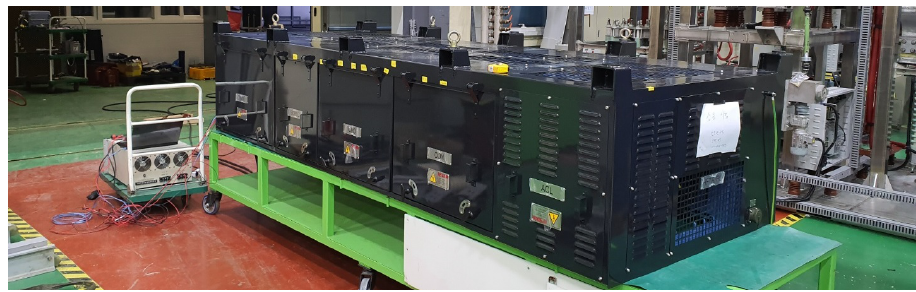
Figure 21. Experimental results of resonant auxiliary power supply for railway